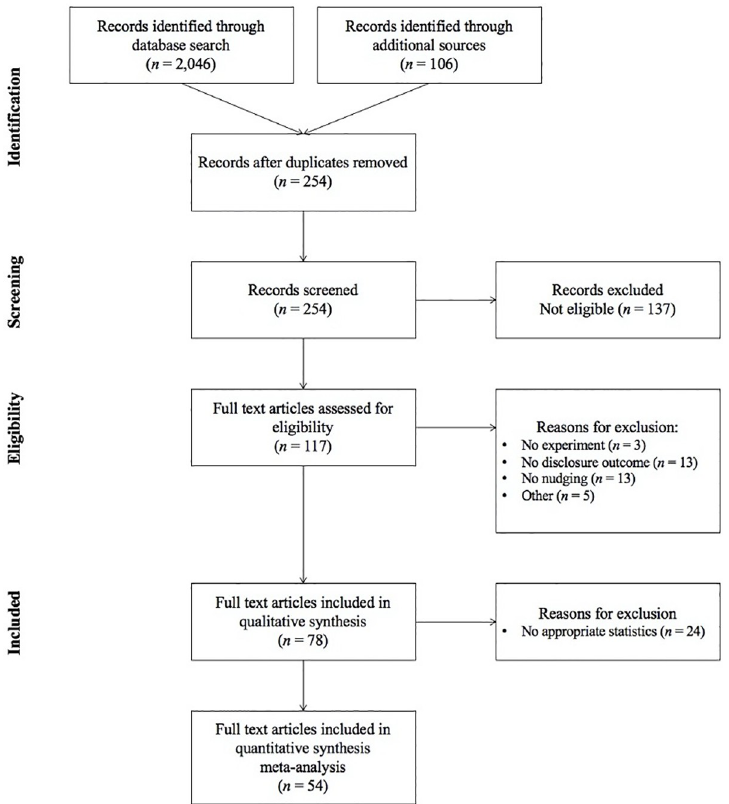
Fig 1. PRISMA flow diagram of information through different stages of